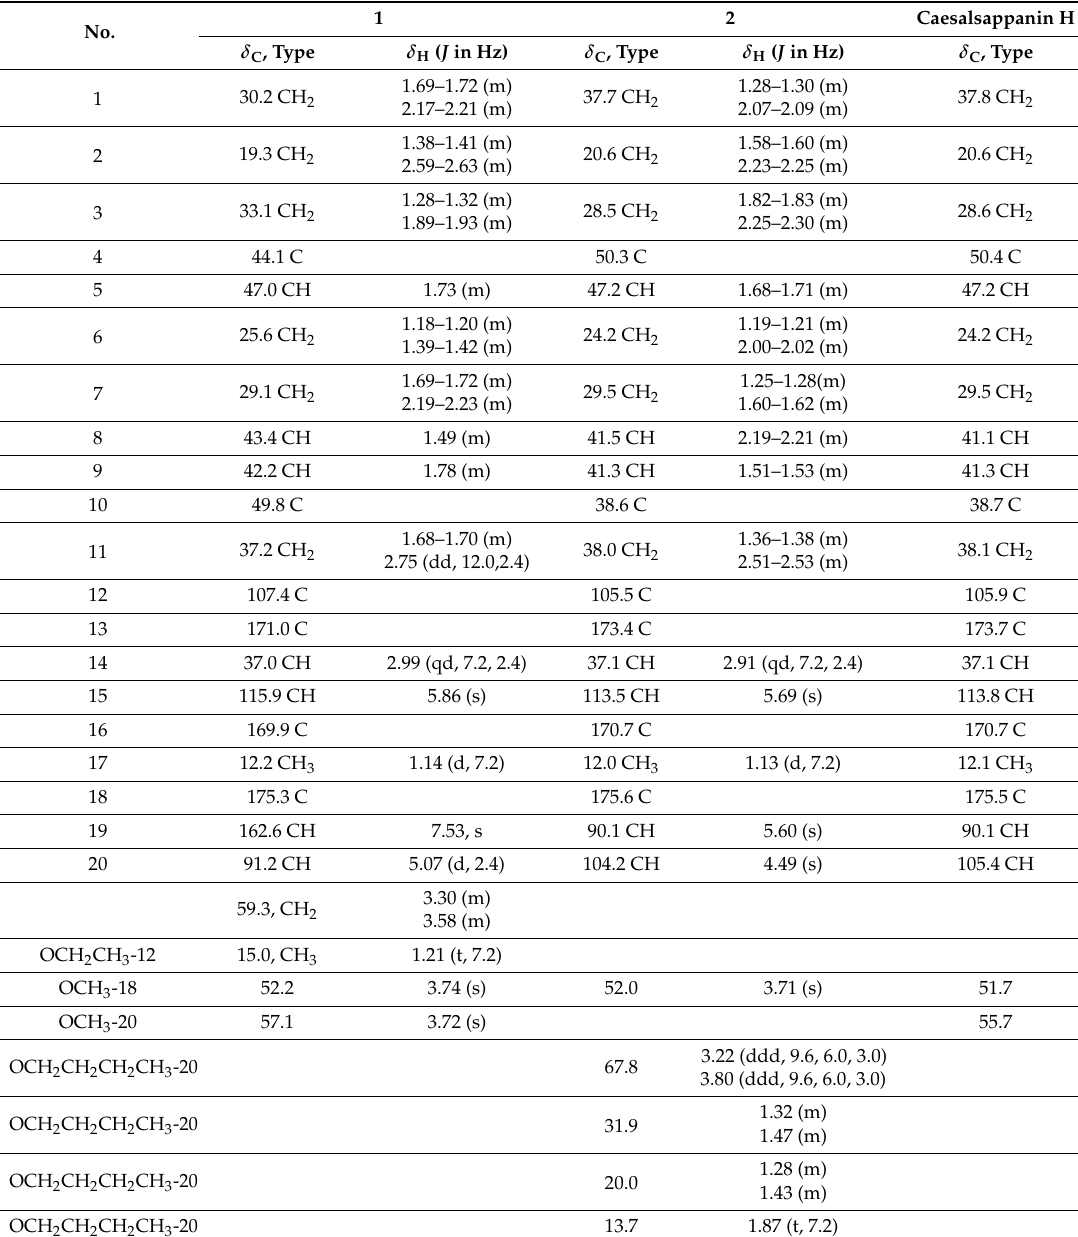
Table 1. NMR spectral data of 1 – 2 (CDCl 3 , 600 and 150